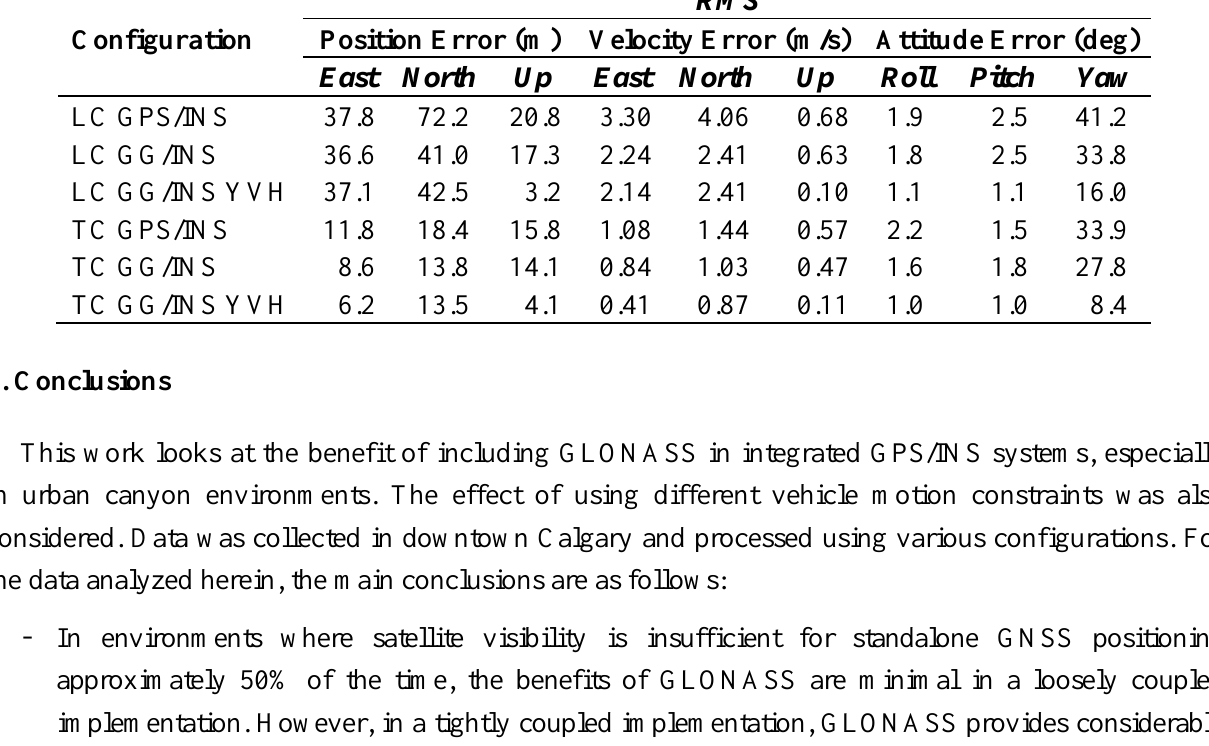
Table 7. Performance comparison between LC and TC configurations for the three segments.